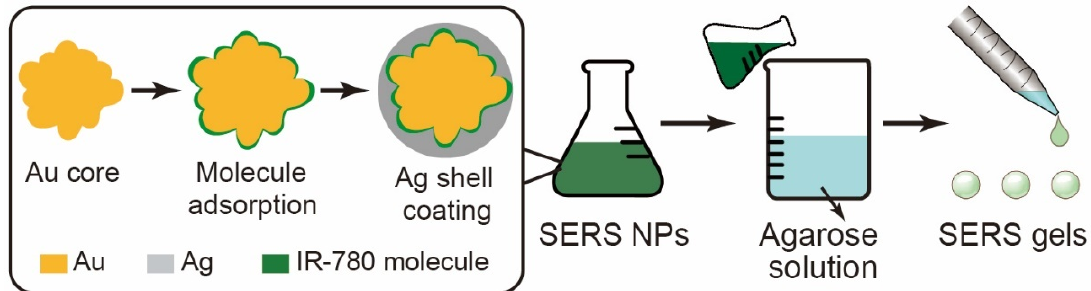
Figure 2. Preparation scheme of SERS NPs and SERS gels.